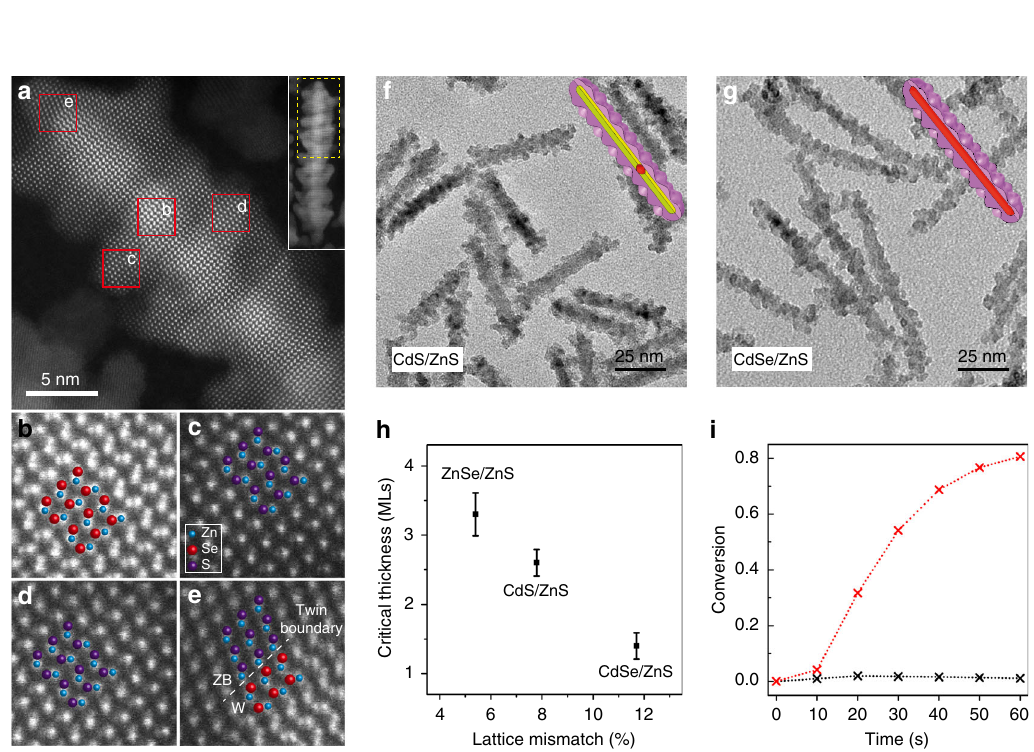
Fig. 2 The generality of three-dimensional islands-shell growth of ZnS on different nanorods. a High-resolution HAADF STEM images of ZnSe/ZnS core/ islands-shell nanorods. Inset shows the whole nanorods, while the yellow dash rectangle is magni fi ed in a . b – e Zoom in images of areas indicated in a . Zn atoms are marked in blue, Se atoms in red and S atoms in purple. f , g TEM images of CdSe/CdS/ZnS and CdSe/ZnS core/islands-shell nanorods. h The dependence of the critical thickness of the wetting layer on lattice mismatch, showing its inverse relation. Error bars (s.d.) originate from the distribution of critical thickness. i Polymerization degree of acrylamide under UV light at 405 nm with intensity of 30 mW/cm 2 using ZnSe (black) and ZnSe/ZnS core/ islands-shell nanorods (red) as photoinitiators in aerobic conditions. The ZnS shell growth is needed to stabilize the rods allowing for its functionality indicates that the original hexagonal structure of ZnSe is not altered after ZnS shell growth. Equivalent analyses focusing on the shell at different regions (areas c and d in Fig. 2a) reveal the epitaxial ZnS shell growth showing atomic arrays coherent with the ZnSe core. Notably, cubic ZnS shell growth can be recognized on the apexes of the ZnSe nanorod, creating a twin boundary along the (002) plane (Fig. 2e). While considering the location of the islands, we performed HRTEM analyses which excluded the